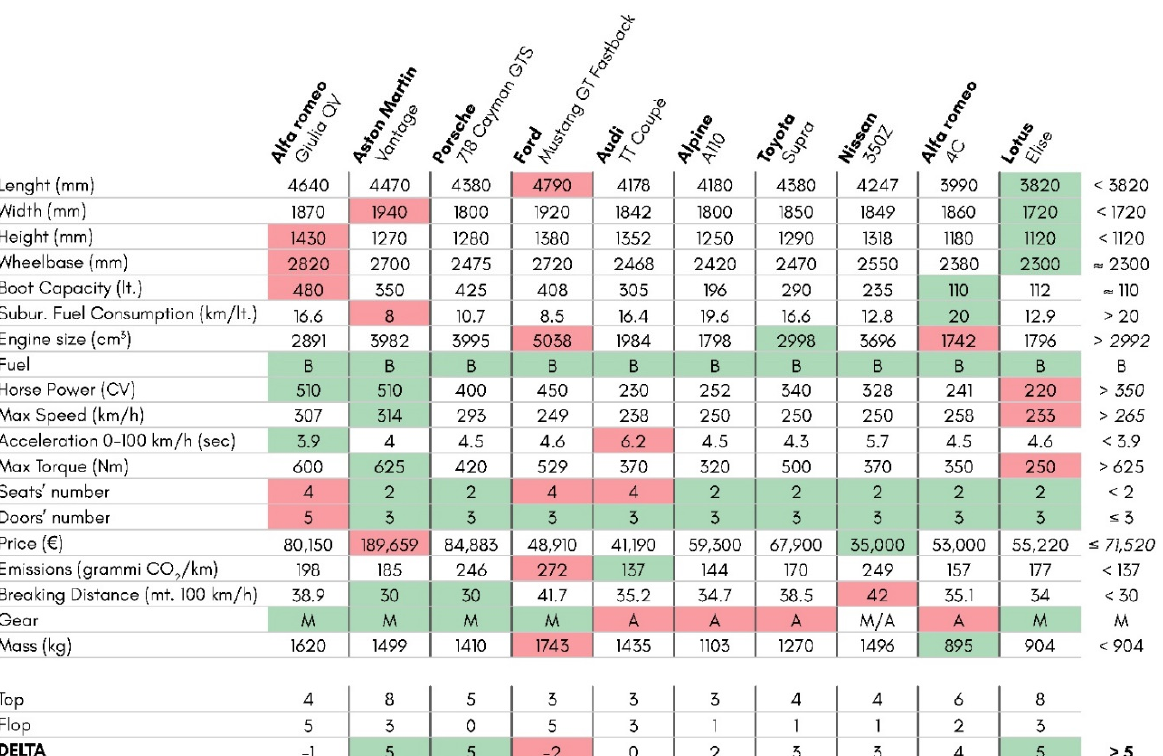
Figure 11. What/How matrix. Activity Planning Before starting the project, a Gantt Plan was defined. All of the different activities that needed to be carried out were added. The timeframe was set from September to De- cember. During this period the team followed the so-called Work Breakdown Structure (WBS). It includes the 14 macro-phases seen in Figure 12, as well as the Gantt that estab- lishes the time available for each activity, as well as which specific team member is as- signed to carry out the various tasks. This allows the users to visualize their workflow and overall progress. It is also a very useful tool when it comes to increasing the deadline observance rate.